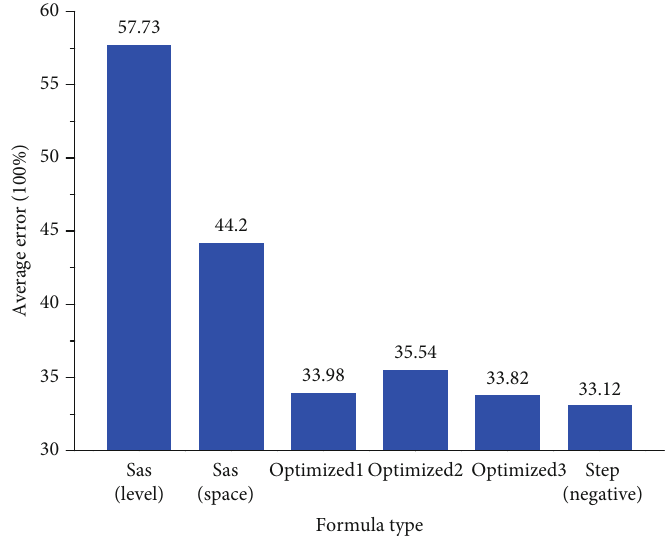
Figure 7: Comparison of prediction